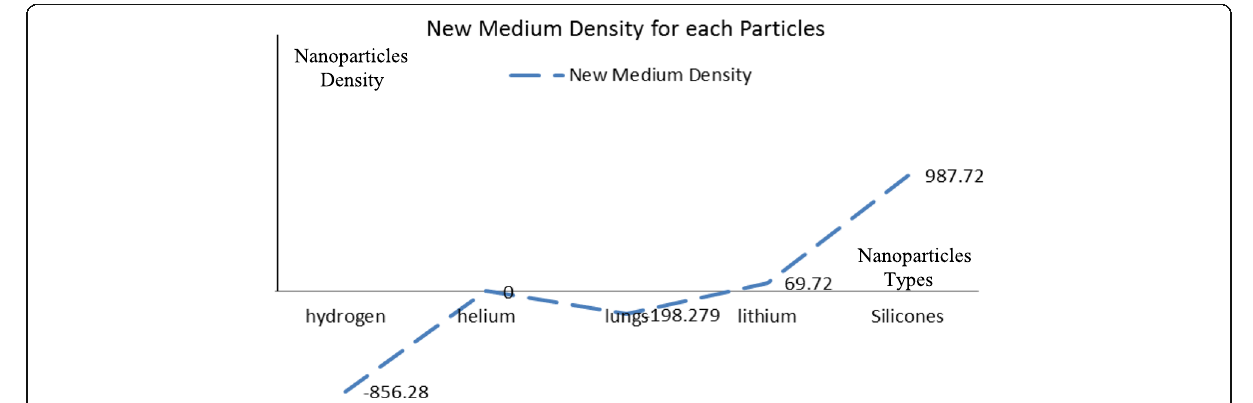
Fig. 6 The effect of the settling velocity of nanoparticles on changing the lymphocyte density of cancer